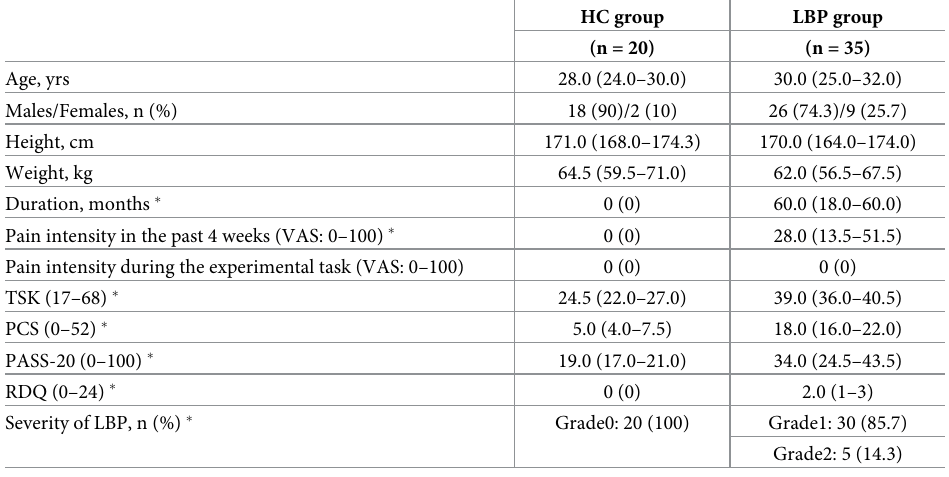
Table 1. Participants’ characteristics and clinical information.